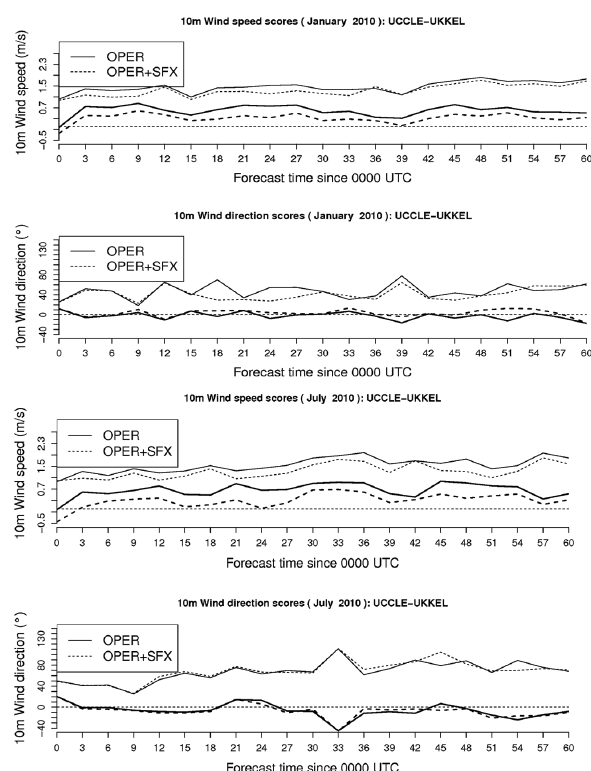
Fig. 7. Statistical scores of 10m wind speed and direction against observations at the suburban Uccle station (bias: thick line; rmse: thin lines) for January (top) and July (bottom) for ALARO with- out SURFEX (OPER, solid lines) and with SURFEX (OPER+SFX, dashed lines)